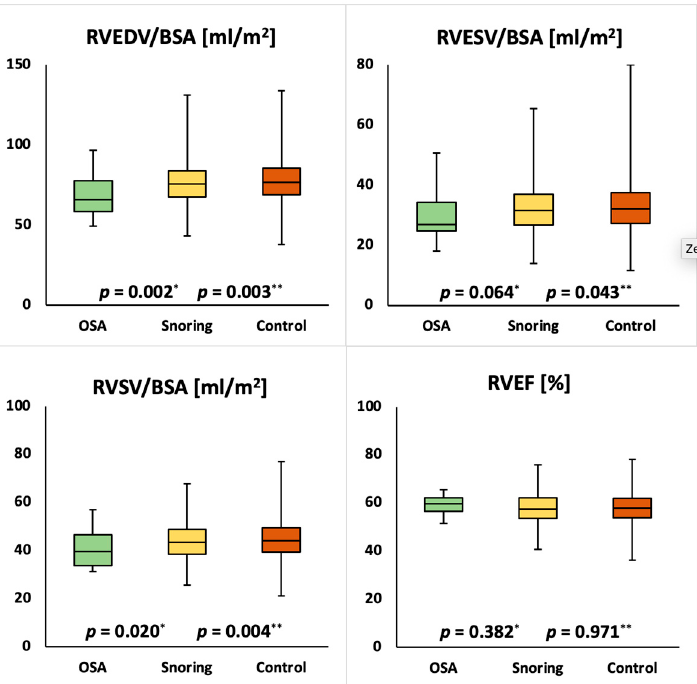
Medicina 2021 , 57 , x FOR PEER REVIEW 7 of 12 Figure 3. Comparison of right ventricular ejection fraction (RVEF) and end-diastolic volume index (RVEDVI), end-systolic volume index (RVESVI) and stroke volume index (RVSVI) in female individuals with obstructive sleep apnea (OSA), snoring or none of the above. p -values for OSA vs. unaffected (*) and snoring vs. unaffected (**) are reported.